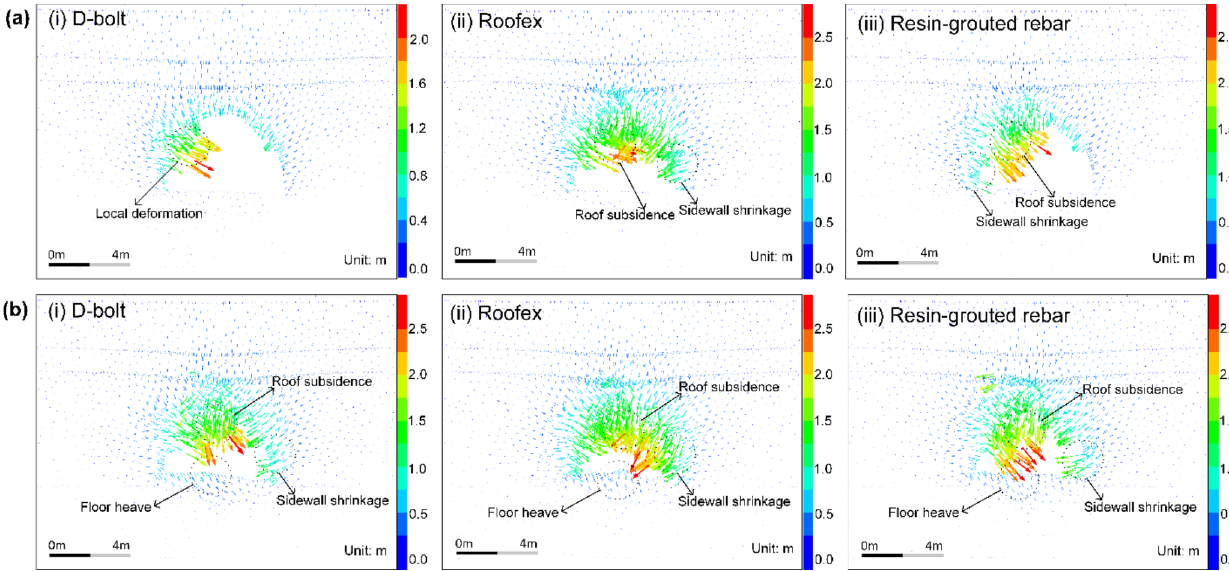
Fig. 12 Simulated displacement vectors of the surrounding rock masses along the tunnel supported by different types of rockbolts. a PPV = 0.2 m/s; b PPV = 0.8